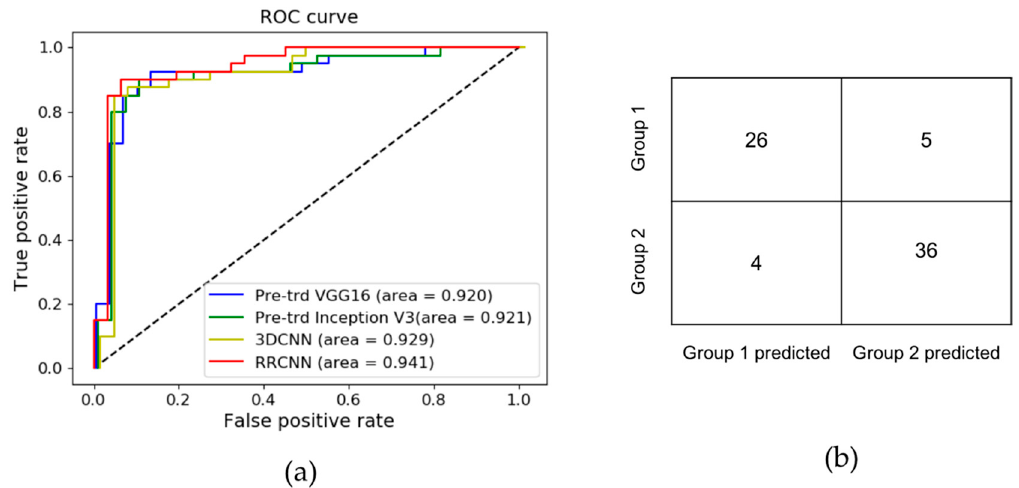
Figure 5. Summary of results using the independent test set. The receiver operating characteristic (ROC) curves are shown for the pre-trained VGG16, pre-trained Inception V3, 3D convolutional neural network (3DCNN), and proposed recurrent residual convolutional neural network (RRCNN) models ( a ). The proposed RRCNN model demonstrated a slightly higher area under the curve (AUC) (0.941) compared to other models. The confusion matrix demonstrates the classification results using the independent test set ( b ).